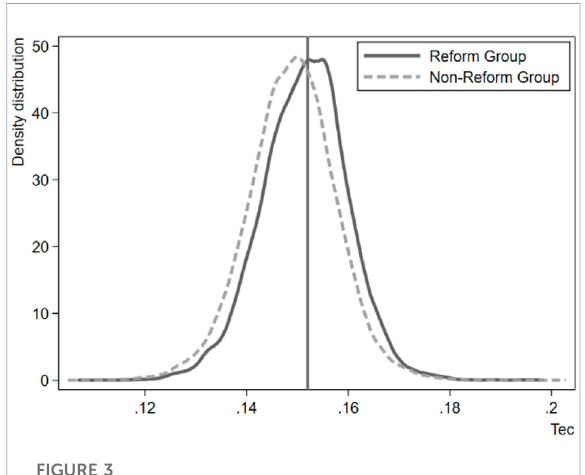
FIGURE 3 Density of tec in reformed and non-reformed